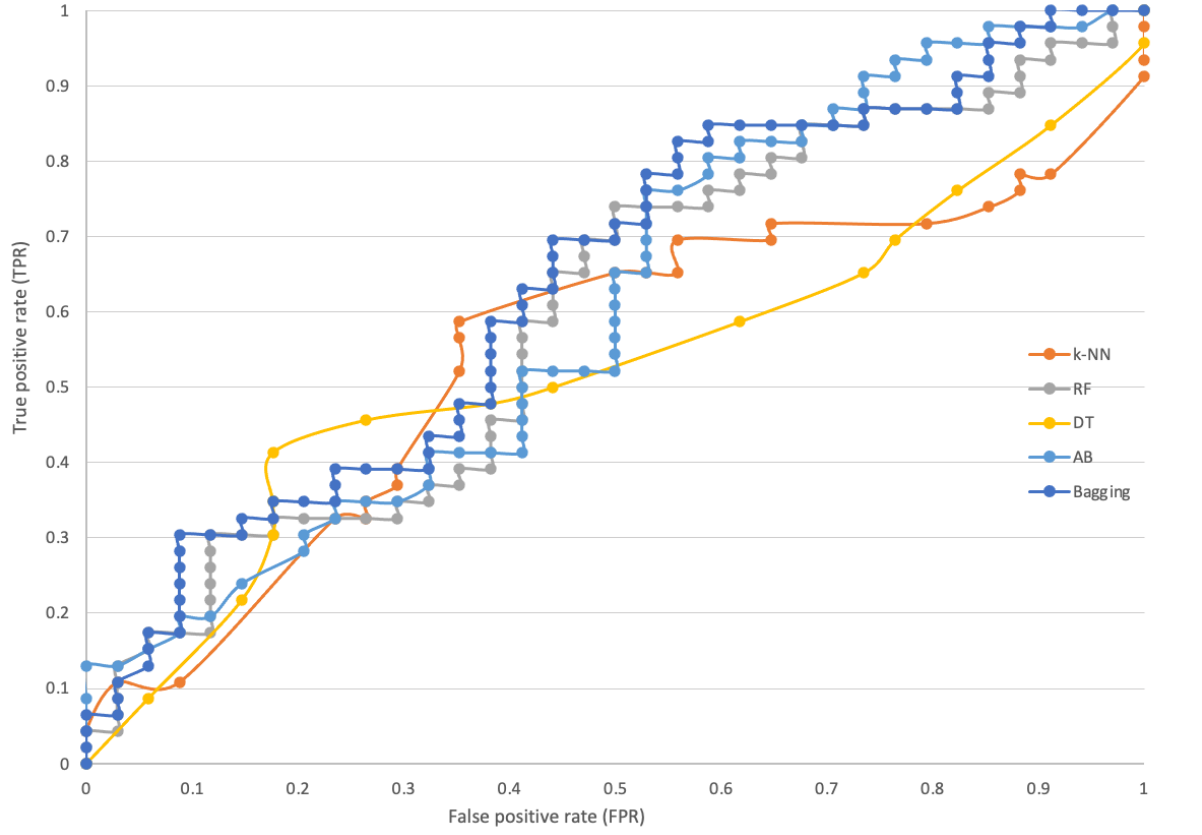
Figure 3. Receiver operating characteristic curves of all classifiers based on original data. AB: AdaBoost; DT: decision tree; k-NN: k-nearest neighbor; RF: random